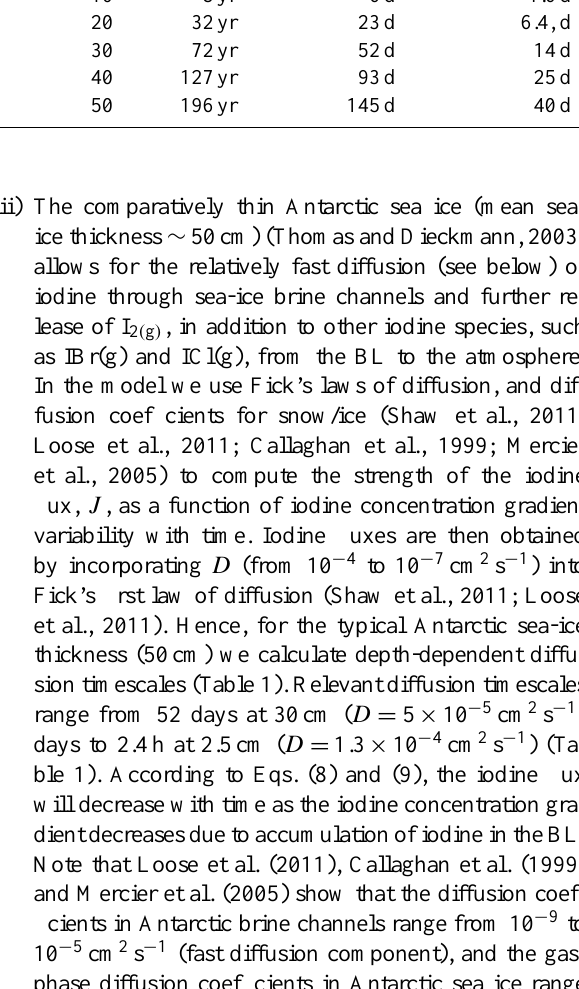
Table 1. Diffusion timescale as a function of depth below sea-ice surface and diffusion coefficient D via the diffusion length equa- tion: L 2 = 4D t , where, L is length (cm) and t is time (s). Depth below D = 10 − 7 D = 5 × 10 − 5 D = 1.3 × 10 − 4 sea-ice cm 2 s − 1 cm 2 s − 1 cm 2 s − 1 surface (cm) 2.5 0.5yr 9h 2.4h 5.0 2yr 2d 9.5h 10 8yr 6d 32yr 127yr 25d 50 196yr 145d